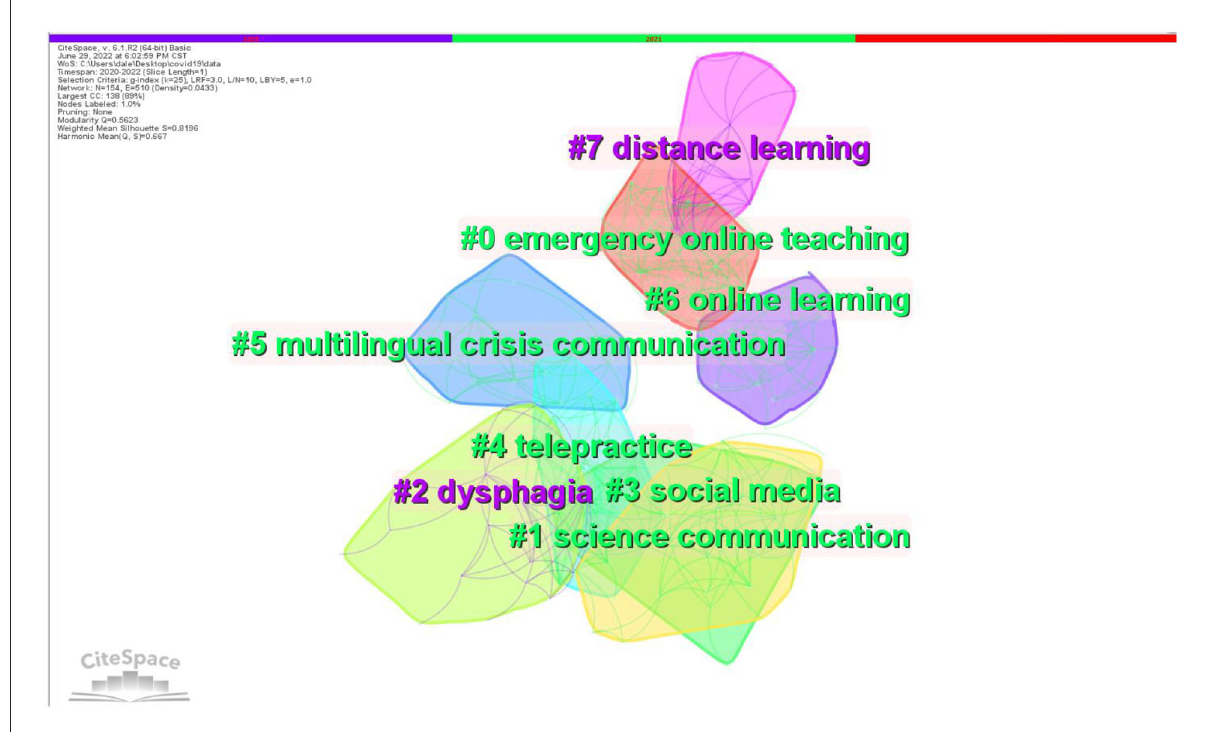
FIGURE4 Cluster view of keyword